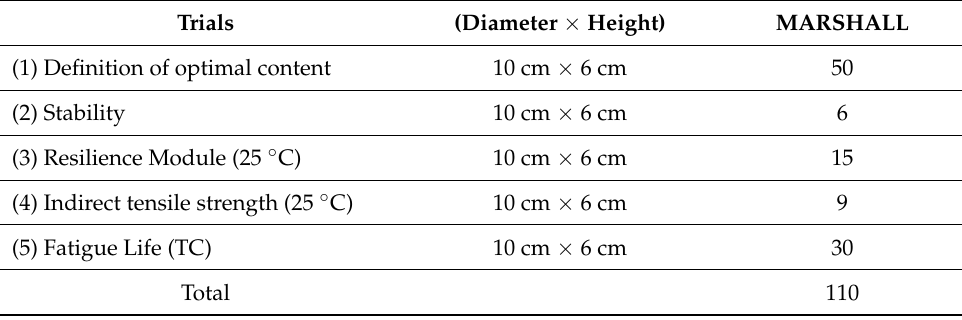
Figure 2. Schematic representation of the mixtures tested in the current study. Table 3. Test bodies used by stage.